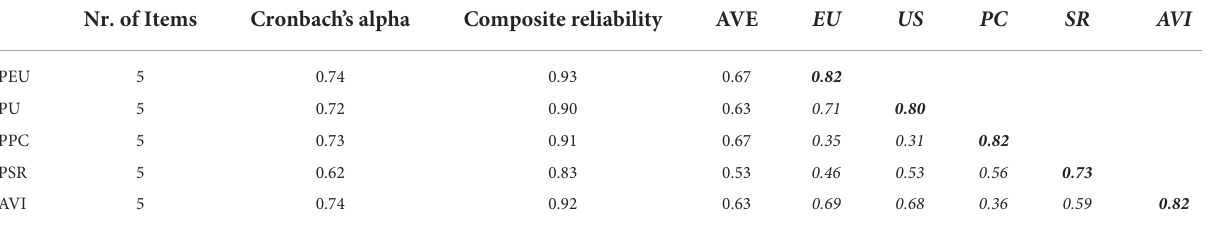
TABLE 5 Assessment of measurement model. Nr. of Items Cronbach’s